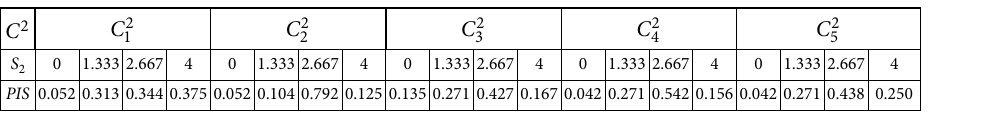
Data from the second survey